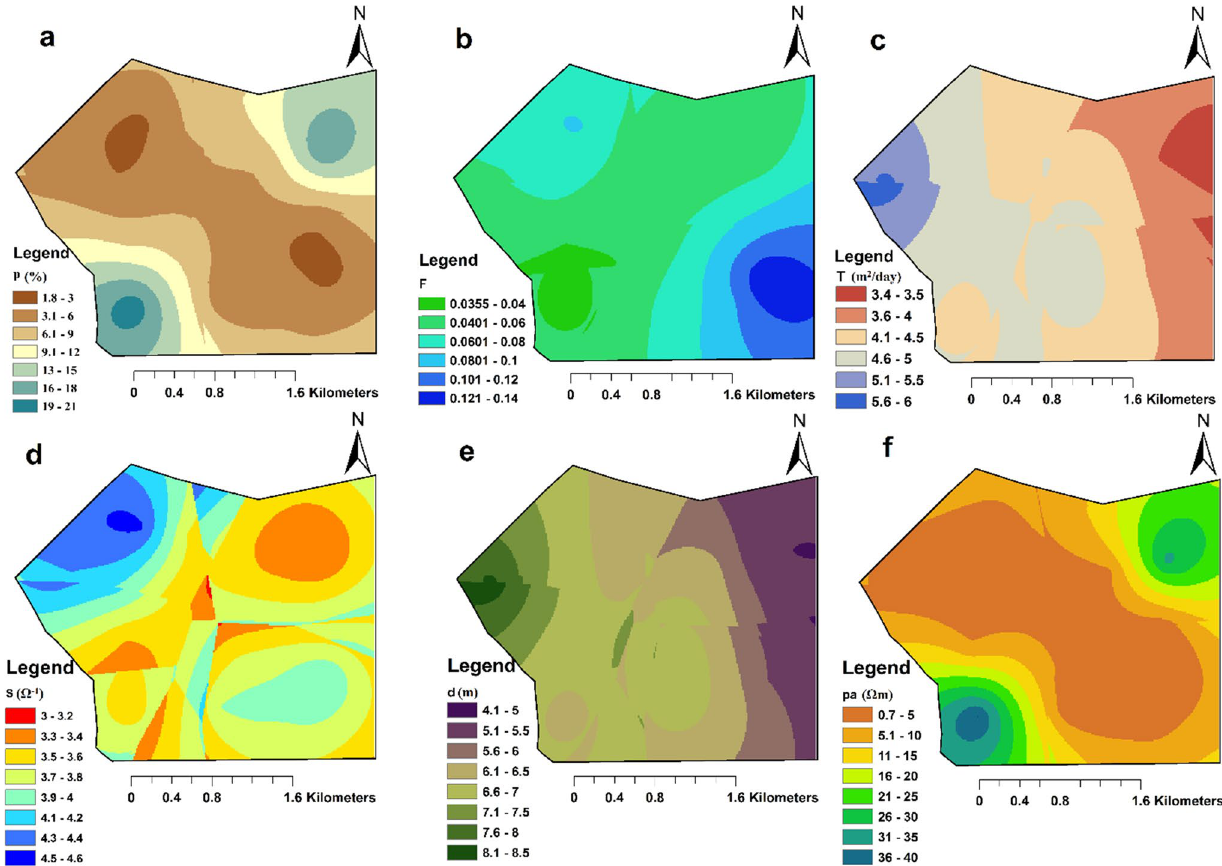
Fig. 4 Criteria layers interpolation using the Kriging method. a Porosity, b formation factor, c transmissivity, d longitudinal conductance, e aqui- fer thickness, and f aquifer